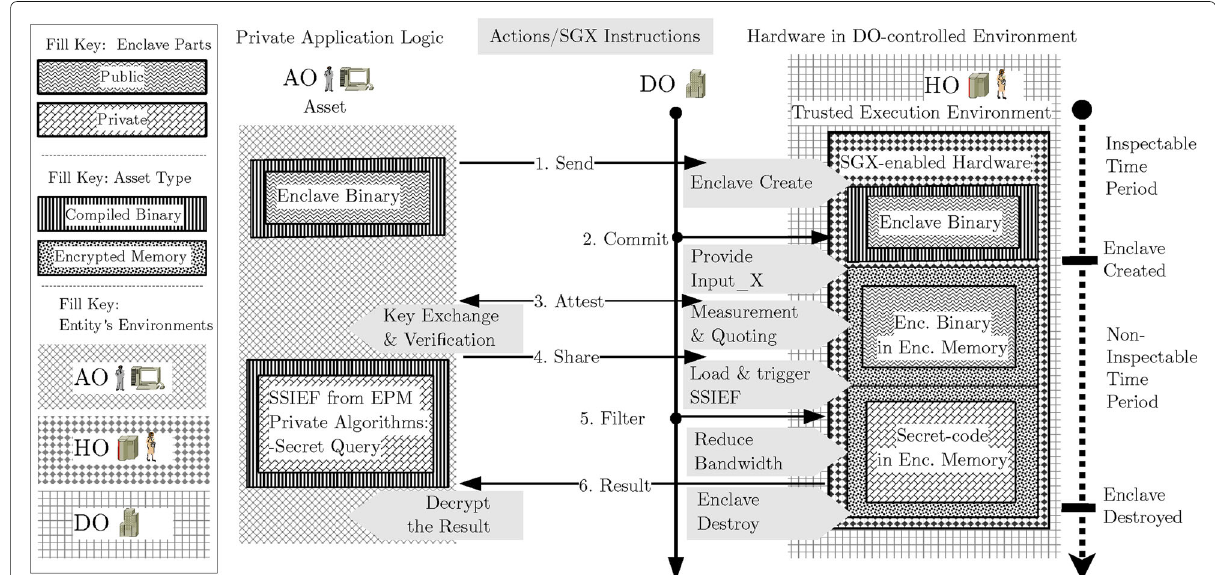
Fig. 11 Secret-Code Execution (SCE) Querying the Data. The AO runs a secret query on a secret data set. After the secret-code execution, the DO has control of the bandwidth for filtering the return value